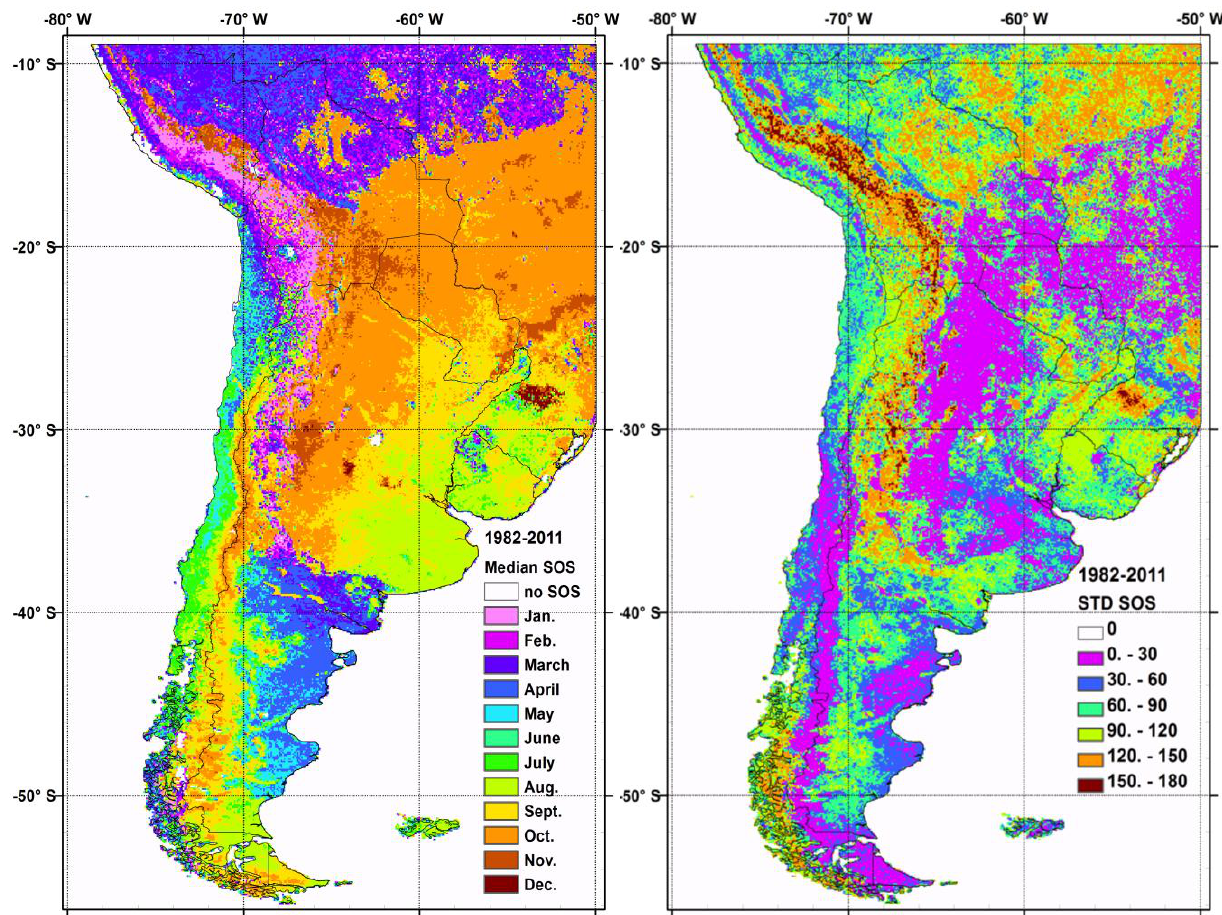
Figure. 6. Median of the SOS based on thirty years of NDVI data. The STD is provided for the annual SOS data. It should be noted that the STD is very variable because of cross calendar year SOS values or high interannual